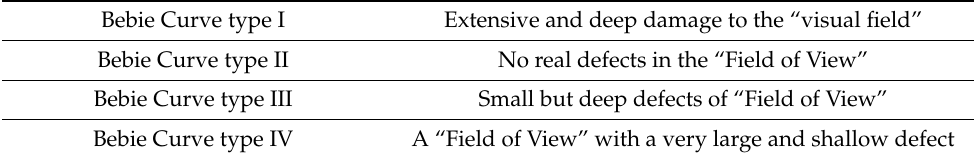
Table 1. Classification of the centralized defect of a VF test result (Bebie